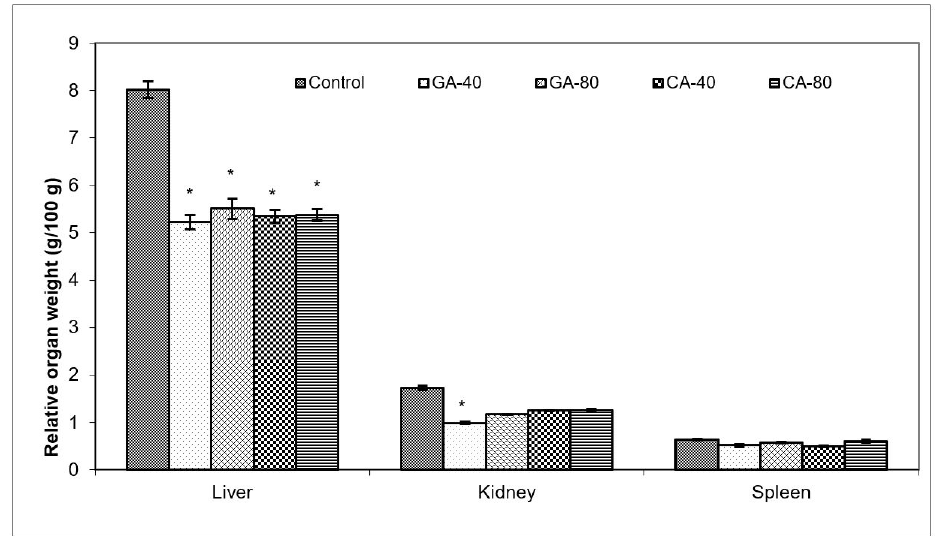
Figure 8. E ff ect of GA and CA on the relative organ weight of mice bearing EAT. Mice were injected intraperitoneally ( ip ) with 2.5 × 10 6 viable EAT cells and treated with GA or CA at a dose of 40 mg / kg and 80 mg / kg ip in exponential tumor growth phase on days 5, 7, 9, and 11. The results are expressed as the mean value of each experimental group ± SE ( n = 7). Mice were sacrificed on the 13th day; liver, kidney and spleen were collected immediately, weighed individually, and the relative weight was calculated as follows: relative organ weight (g / 100 g) = total organ weight x 100 / final body weight. Data are reported as the mean ± SE of the mean of three di ff erent observations; * p < 0.05, as